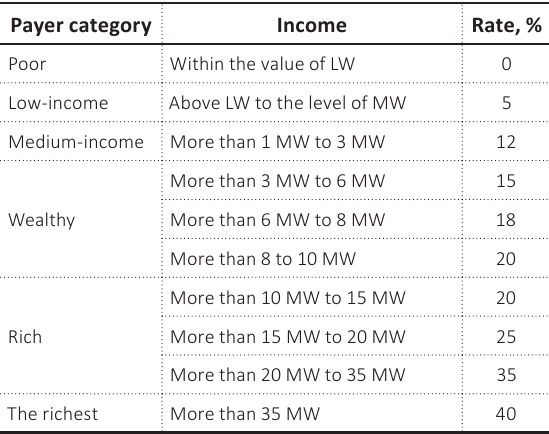
Table 2. The proposed scale of personal income taxation in Ukraine